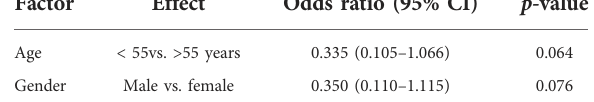
TABLE 2 Intraoperative factors.